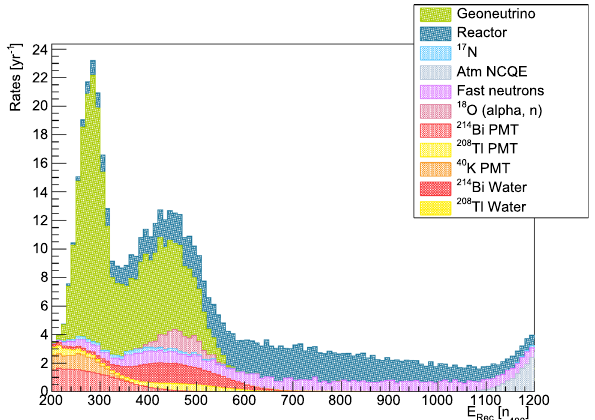
Fig. 7 Stacked PDF spectra of all signal and background contributions in the ROI optimized for geo and reactor combined signal